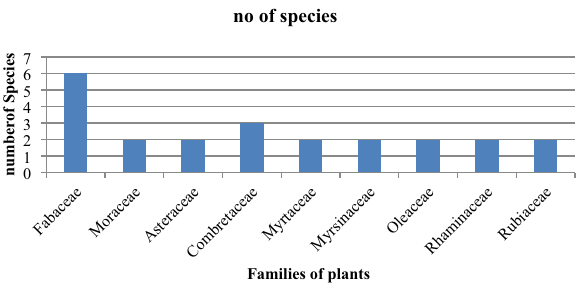
Fig. 2 Families of plants with highest number f plant species